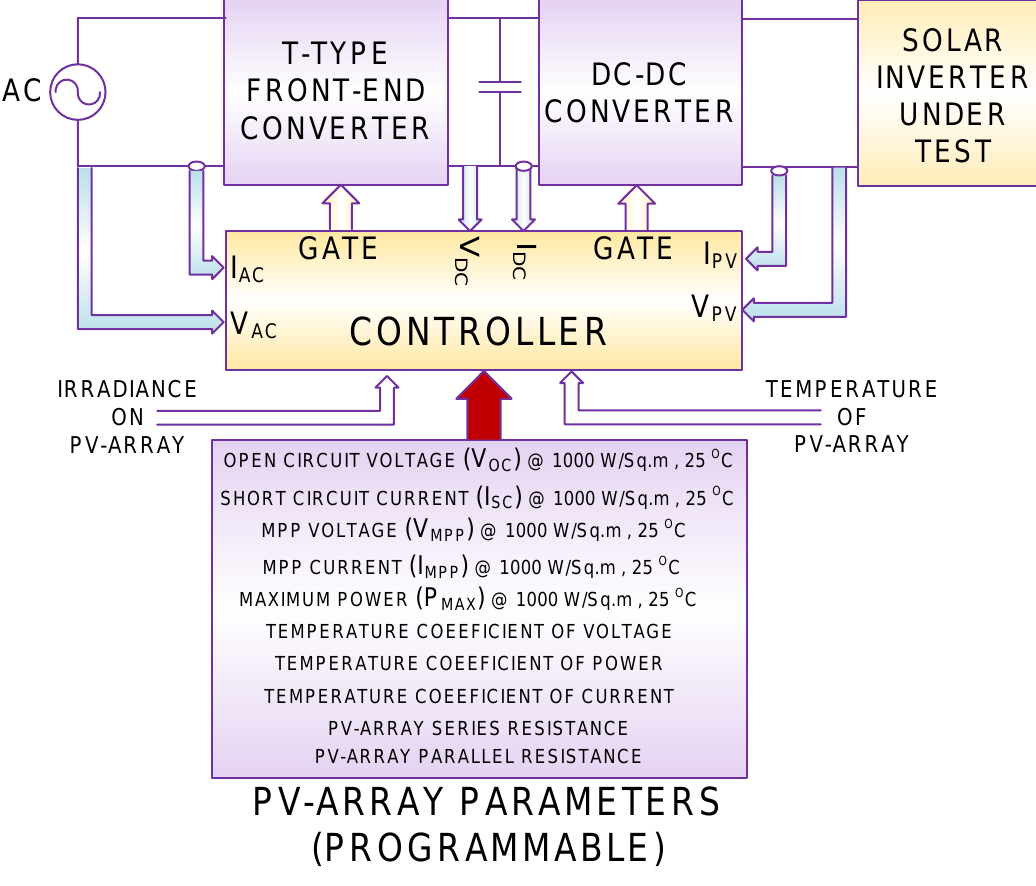
Figure 1. Block diagram of the proposed PV-Simulator.